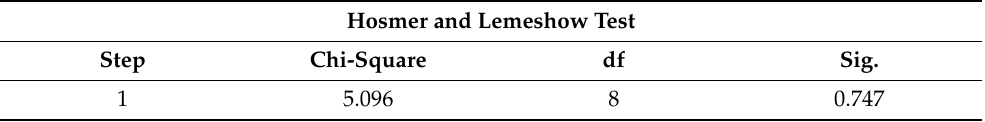
Table 16. Hosmer and Lemeshow test